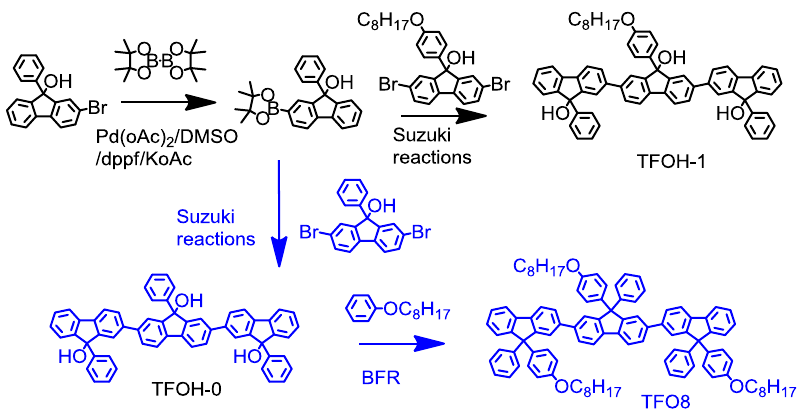
( a ); 1 H NMR spectra of TFOH-1 in different 3 and concentrations; ( b , c ) 2 mg/mL 3